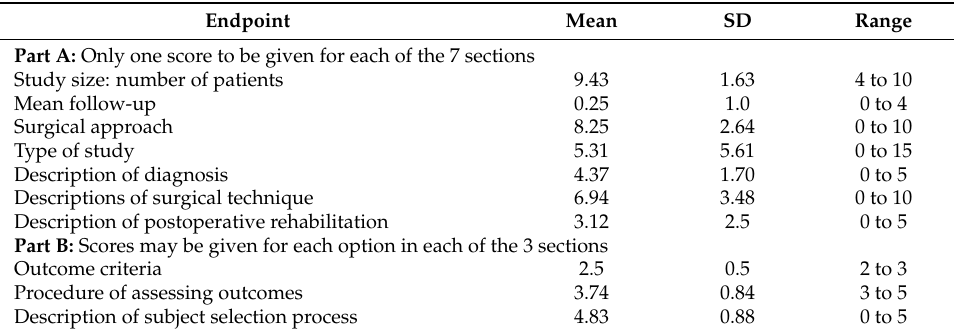
Table 1. Methodological quality assessment.